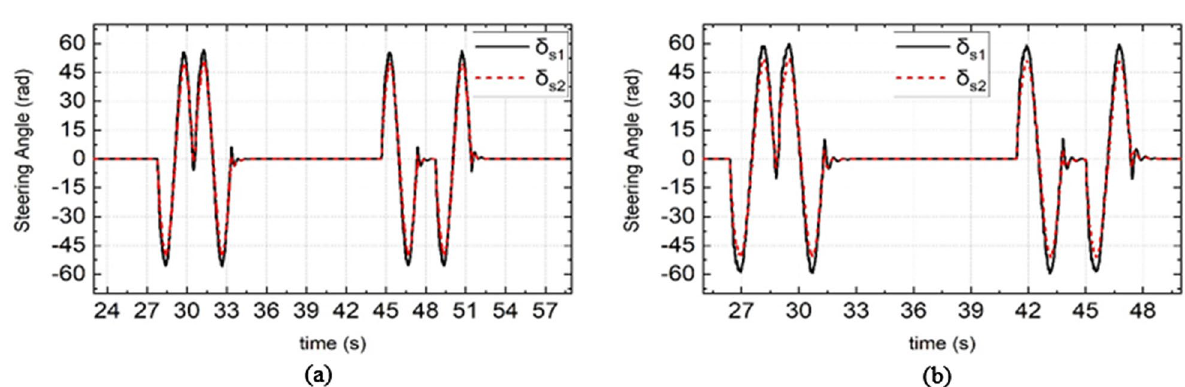
Figure 8. Simulation results of steering wheel angle under different road adhesion coefficient and different vehicle speed. ( a ) Is the simulation results of DDAV running at 40 km/h on wet road, ( b ) is the simulation results of DDAV running at 45 km/h on dry